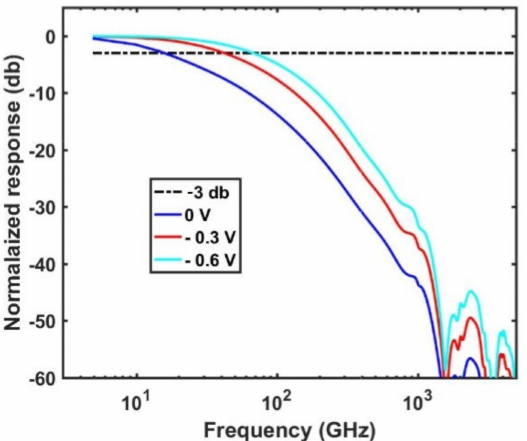
Figure 6. The transit-time bandwidths of the device ( R = 175 nm and H = 275 nm) at 0 V, − 0.3 V, and − 0.6 V are 16, 42, and 65 GHz,